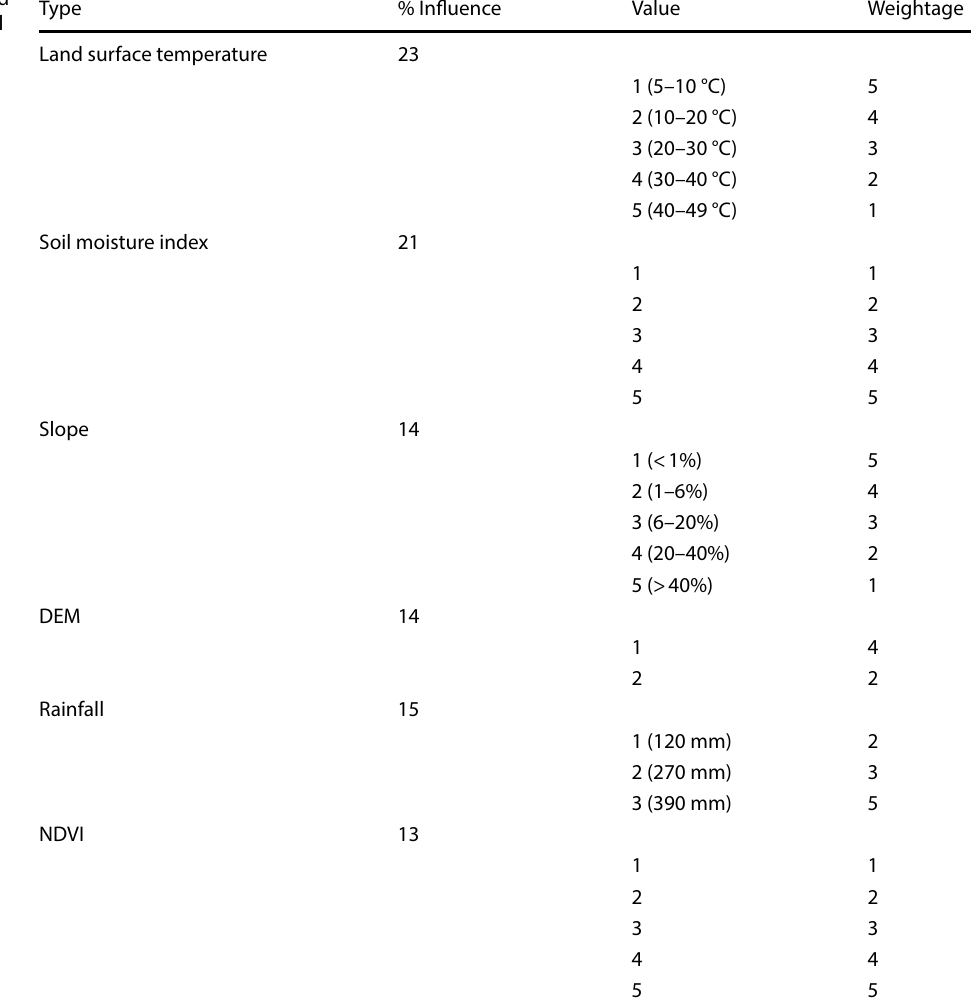
Table 2 Assigned weights and Type % ranks for agriculture potential